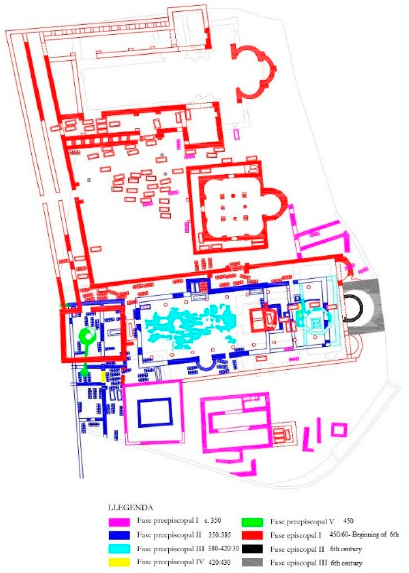
Figure 5. Architectural phases of the complex of Terrassa. According to G. Garcia, A. Moro, and F. Tuset. © G.Garcia, A. Moro and F. Tuset (with kind permission).